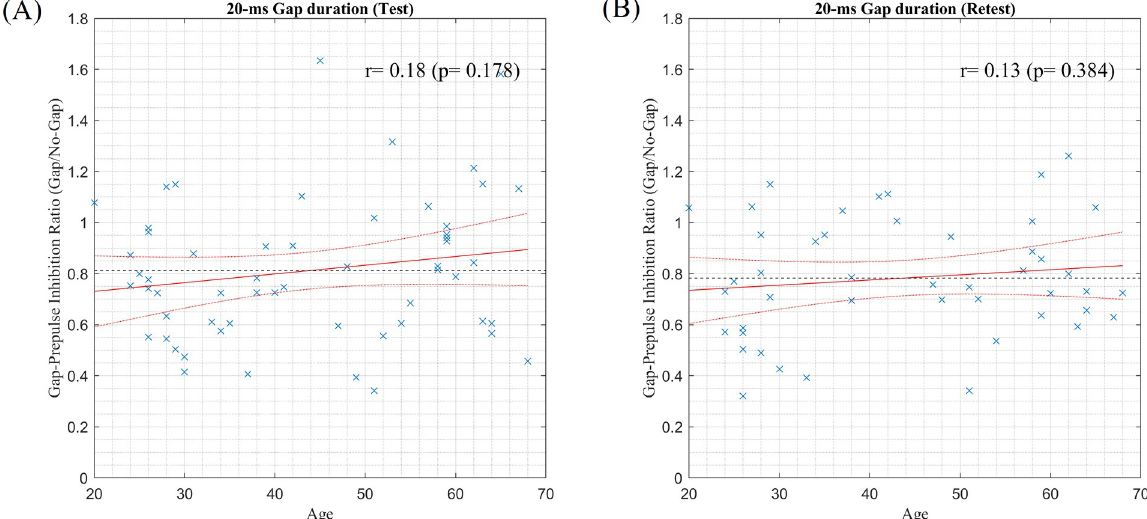
Fig 5. Scatter plots of age versus Gap/No-gap ratio with a 20-ms gap duration in the test (A) and retest (B) sessions. The red solid and dotted lines indicate the fitting line and 95% confidence bounds, respectively, based on the linear regression analysis. The black dotted line indicates the average of all Gap/No-gap